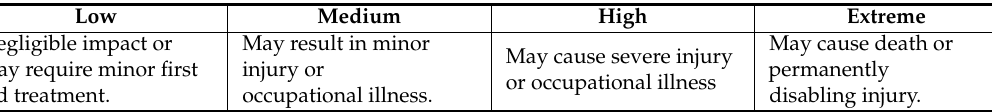
Table 3. Qualifications of risk levels [15].